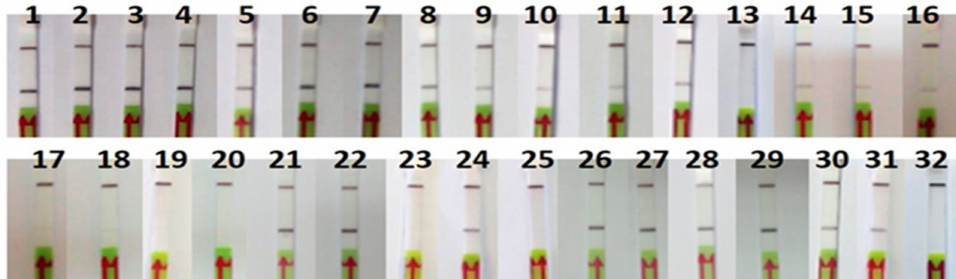
Figure 6. Lateral flow strips showing RPA-LFA test results of commercial samples ( n =